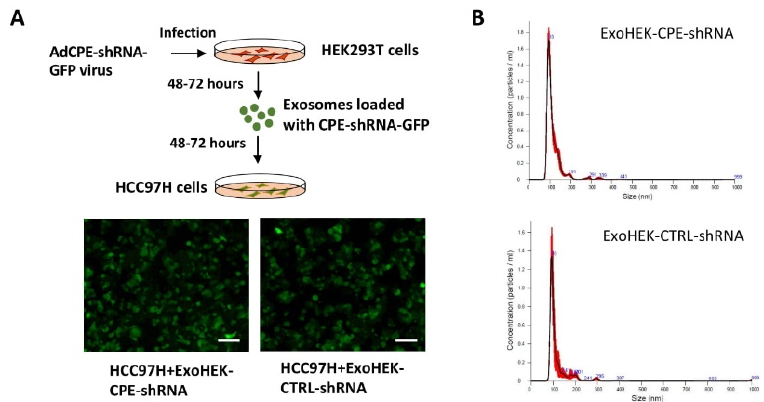
Figure 5. Characterization of exosomes loaded with CPE-shRNA. ( A ) Schematic showing the strategy of loading and transfer of CPE-shRNA via exosomes. Exosomes were isolated from supernatant media of HEK293T cells (ExoHEK) infected with adenovirus encoding either CPE-shRNA or CTRL-shRNA, fused to GFP. HCC97H cells treated with these modified exosomes exhibited green fluorescence, validating the transfer of CPE-shRNA through the exosomes. Representative images showing GFP fluorescence in target HCC97H cells, treated with either ExoHEK-CPE-shRNA or ExoHEK-CTRL-shRNA are included. Scale bar = 100 µm. ( B ) Graph showing the concentration and size distribution of ExoHEK-CPE-shRNA and ExoHEK-CTRL-shRNA, as determined by NanoSight analysis.